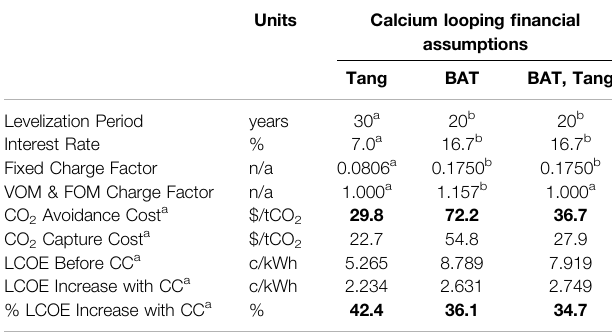
TABLE6| ComparisonofcalciumloopingKIPsasafunctionofvariouslevelization periods, interest rates and VOM, FOM charge factors.